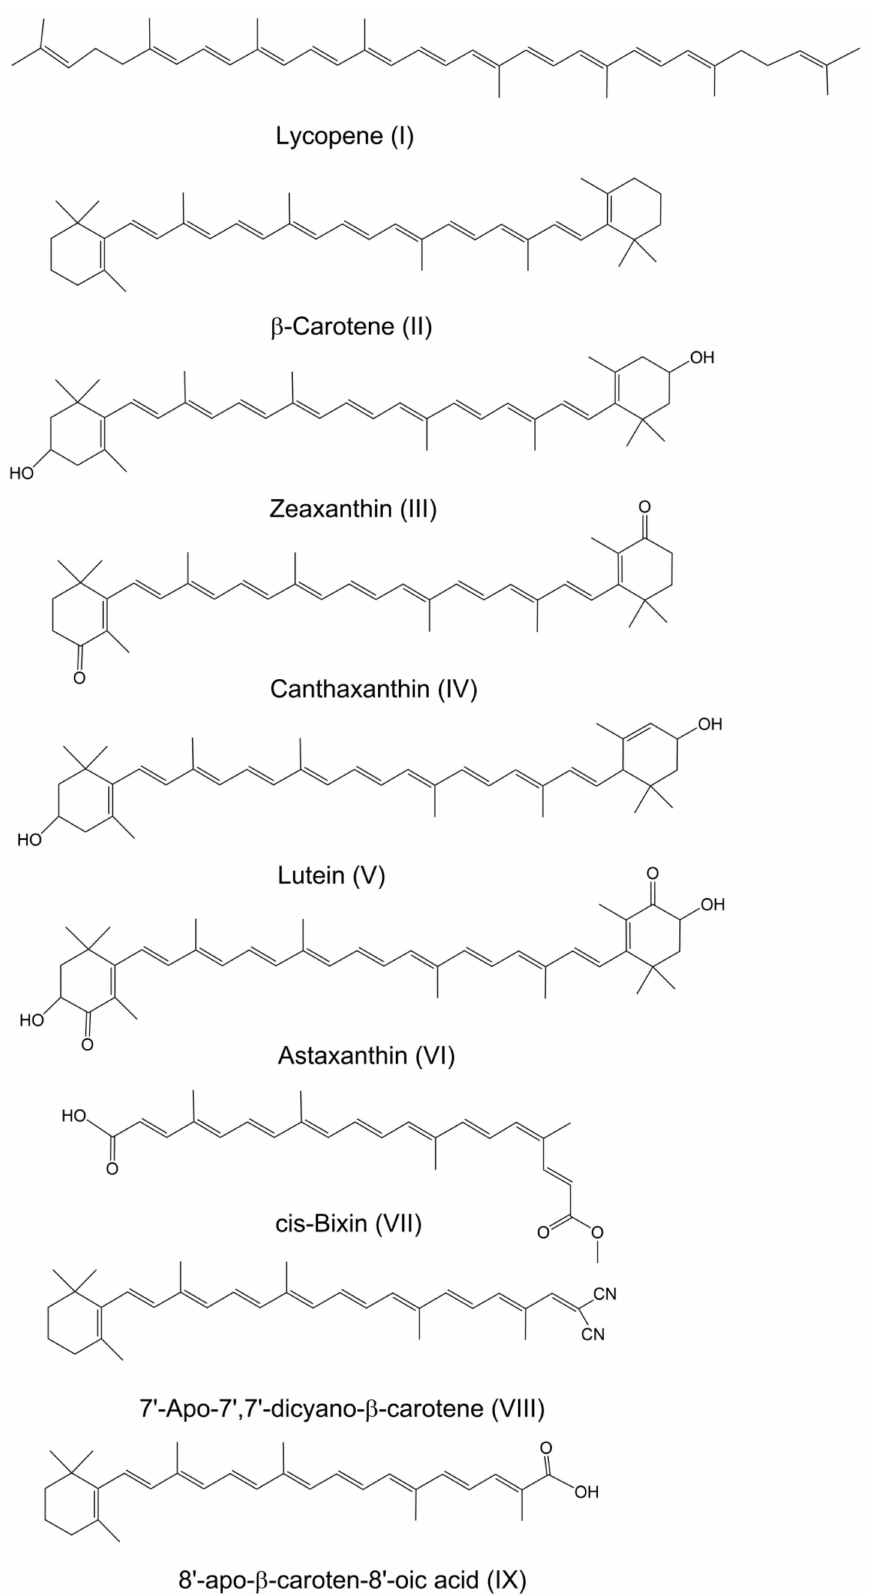
Figure 1. The ground state structures of selected natural and synthetic carotenoids I – IX